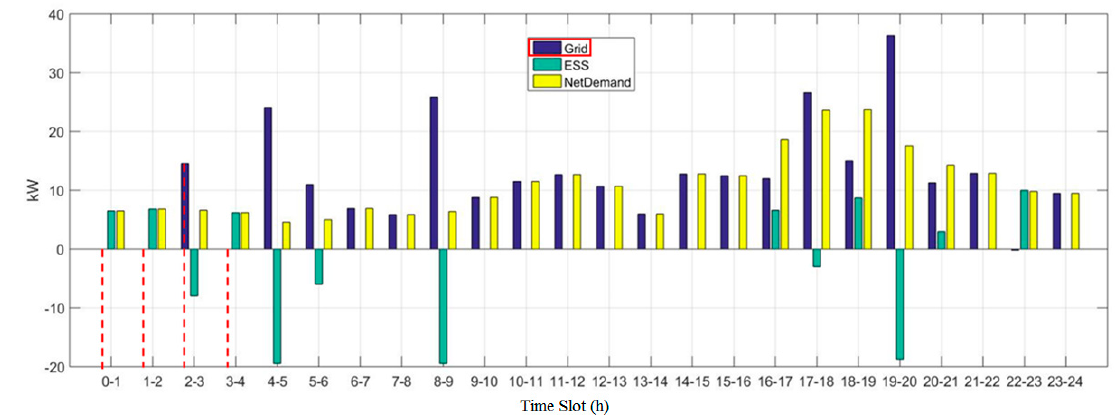
Figure 13. The application result of demand response. Processes 2019 , 7 , 80